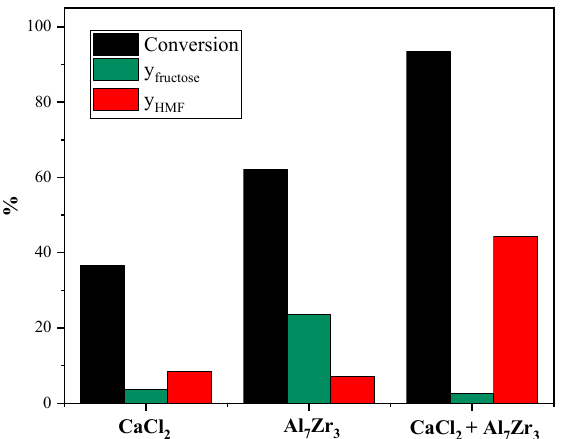
Figure 8. E ff ect of adding CaCl 2 without or with Al 7 Zr 3 catalyst (150 ◦ C, 90 min, glucose / catalyst weight ratio of 3 and / or 0.65 g CaCl2 · g aq.sol. − 1 Figure 8. Effect of adding CaCl 2 without or with Al 7 Zr 3 catalyst (150 °C, 90 min, glucose/catalyst weight ratio of 3 and/or 0.65 g CaCl2 ·g aq.sol. − 1 ).